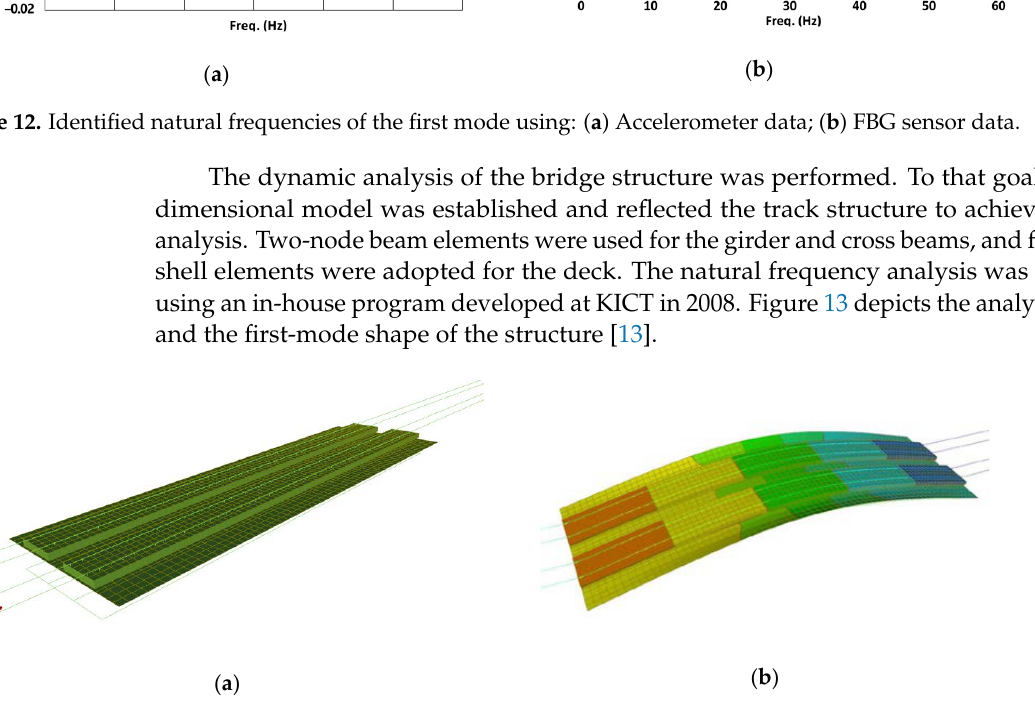
Figure 13. Dynamic analysis: ( a ) Three-dimensional FE model; ( b ) First-mode shape of BH girder bridge prototype [13].